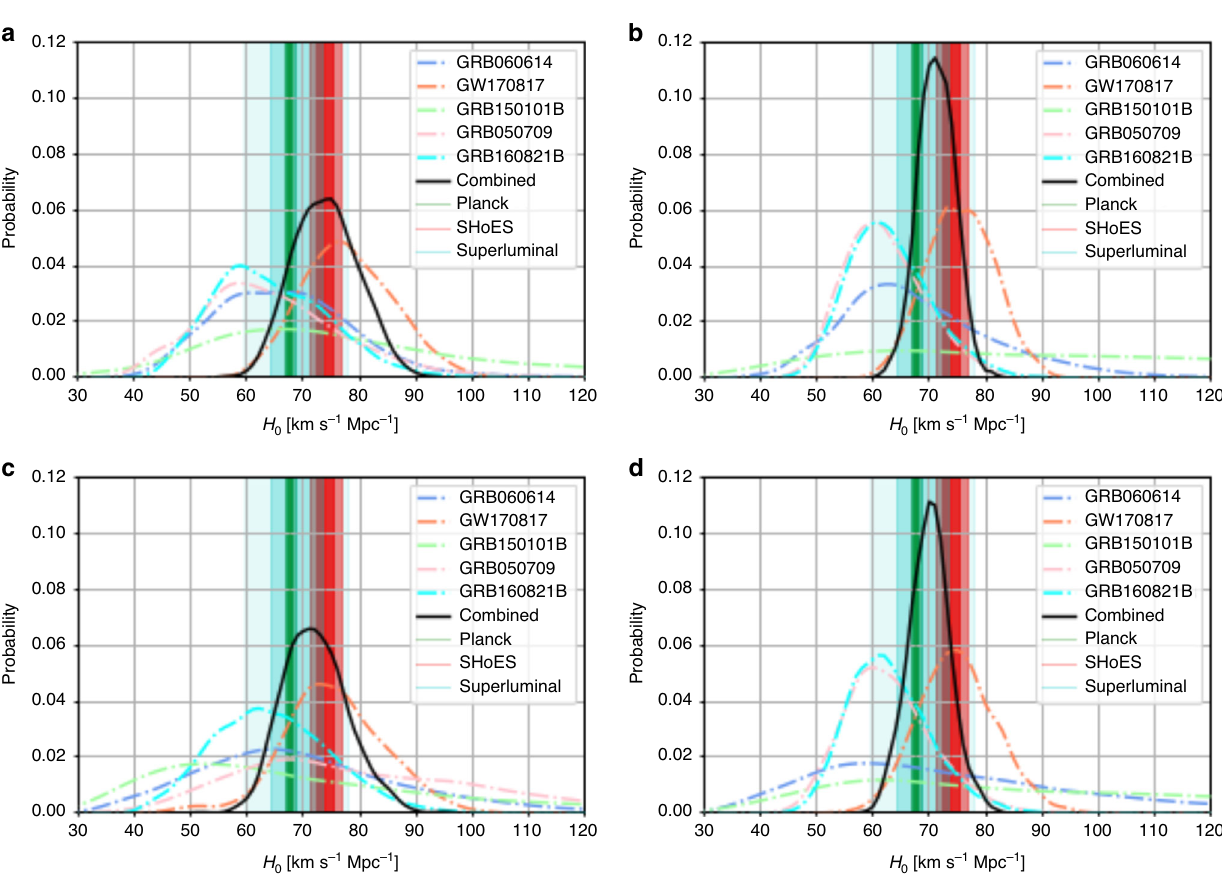
Fig. 1 Posterior distributions for H 0 for individual events. We show GW170817, GRB 060614, GRB 150101B, GRB 160821B, GRB 050709, and their combined posteriors. Fig. a is the Kasen 24 model with 0.1 mag errors, b is the Bulla 25 model with 0.1 mag errors, c is is the Kasen model with 0.25 mag errors, and d is is the Bulla model with 0.25 mag errors. The 1- and 2- σ regions determined by the superluminal motion measurement from the radio counterpart (blue) 16 , Planck CMB (TT,TE,EE + lowP + lensing) (green) 34 and SHoES Cepheid-SN distance ladder surveys (orange) 5 are also depicted as vertical bands.